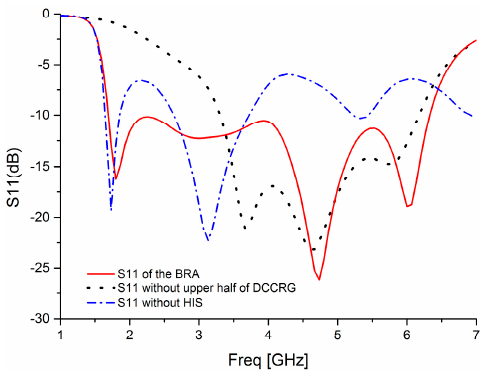
Figure 6. Comparison of the S11 between the BRA ( the red line ) and the antenna without upper half of DCCRG ( the black line ), and S11 of the antenna without HIS ( the blue line ).